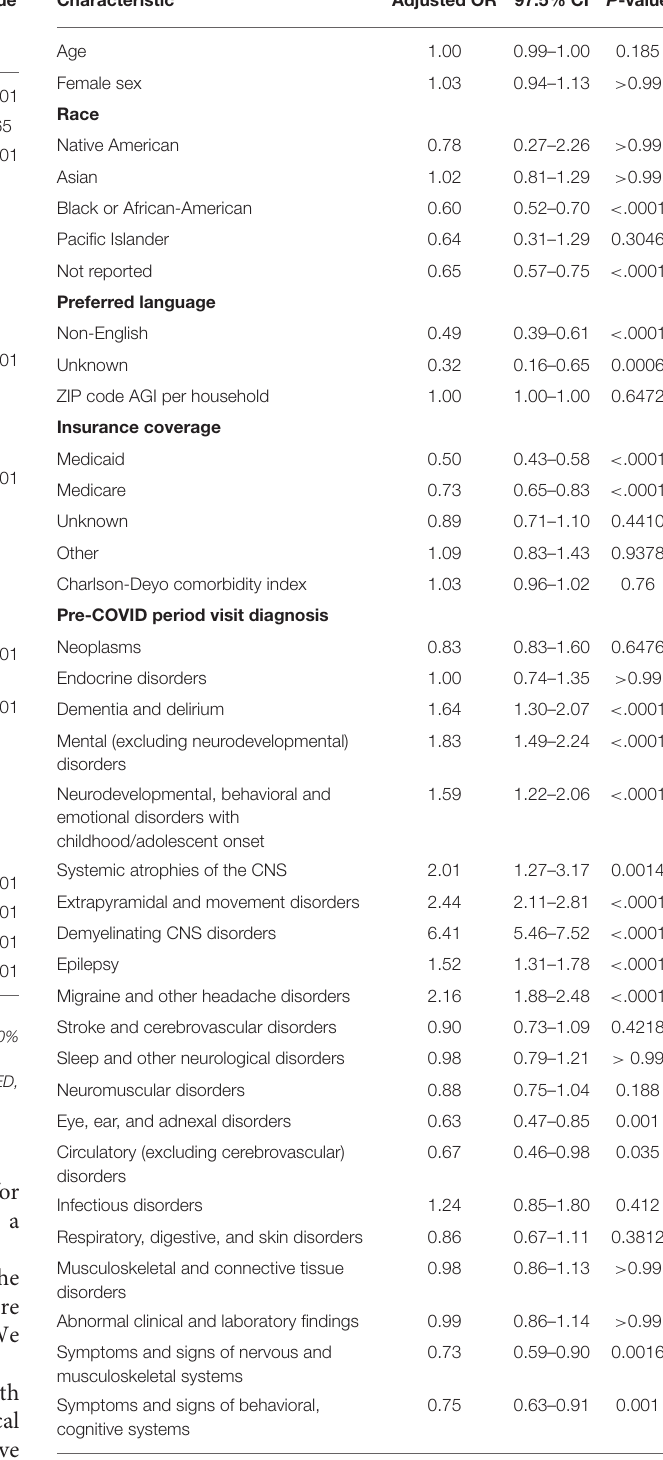
TABLE 2 | Sensitivity analysis of TN utilization during the COVID period, excluding patients lost to follow-up. Characteristic